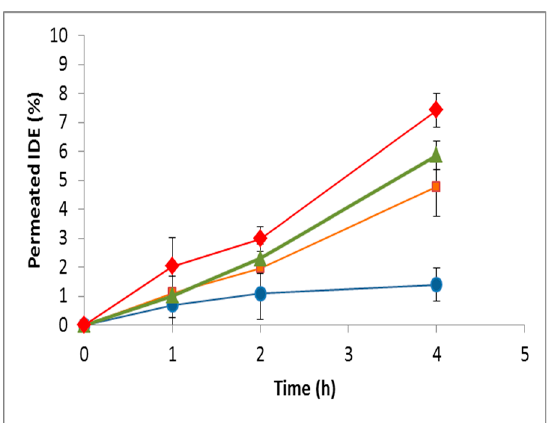
Figure 20. Permeation profiles across the excised bovine nasal mucosa of free IDE (blue circles) and in the presence of increasing amounts of HP- β -CD. Orange squares: 1:2 IDE:HP- β -CD inclusion complex, green triangles: 5% HP- β -CD, red diamond: 10% HP- β -CD. Results are presented as the means of six different experiments ± standard deviation.